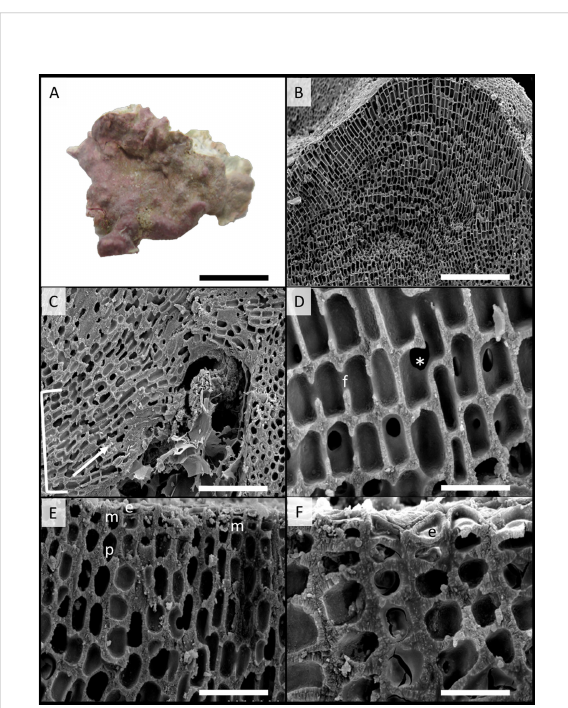
FIGURE 5 Scanning electron microscopy images of Phymatolithon abuqirensis voucher TS 757 (LAF 7722). (A) Habit view of thallus, scale bar = 1 cm. (B) Section view of thallus, scale bar = 200 µm. (C) Section view showing hypothallium (bracket) with monomerous thallus construction and hypothallial cells ’ direction of growth (white arrow), scale bar = 100 µm. (D) Magni fi ed view of perithallium with adjacent perithallial cells linked by cell fusions in the x-axis (f) and z-axis (*), scale bar = 20 µm. (E) Section showing domed epithelial cells (e), meristematic cells (m), and tear-dropped shaped perithallial cells (p), scale bar = 30 µm. (F) Magni fi ed view of surface cells, emphasizing the domed epithelial cells (e), scale bar = 20